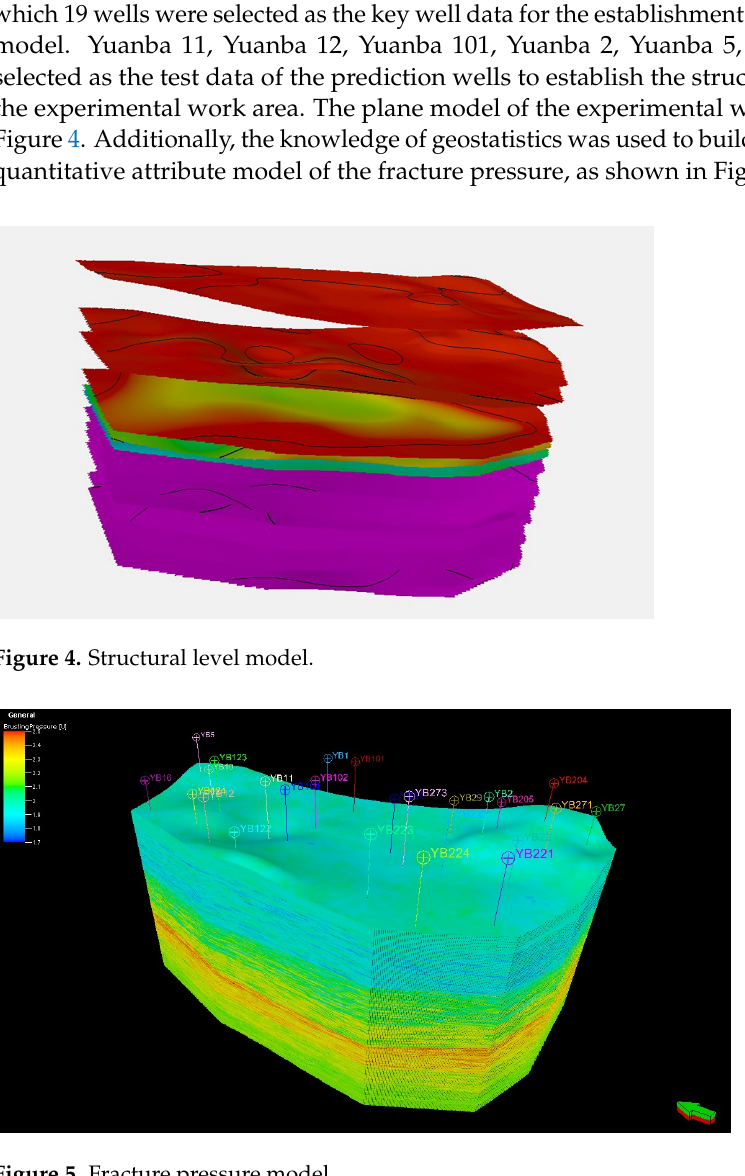
Figure 5. Fracture pressure model.